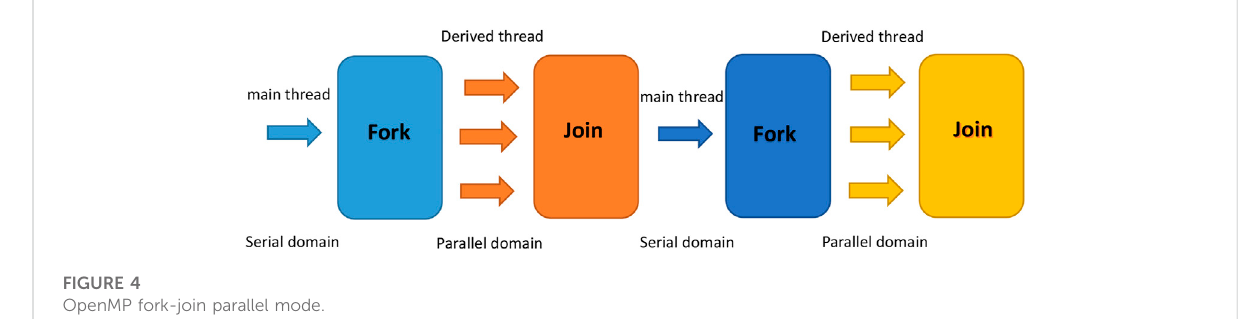
FIGURE 4 OpenMP fork-join parallel